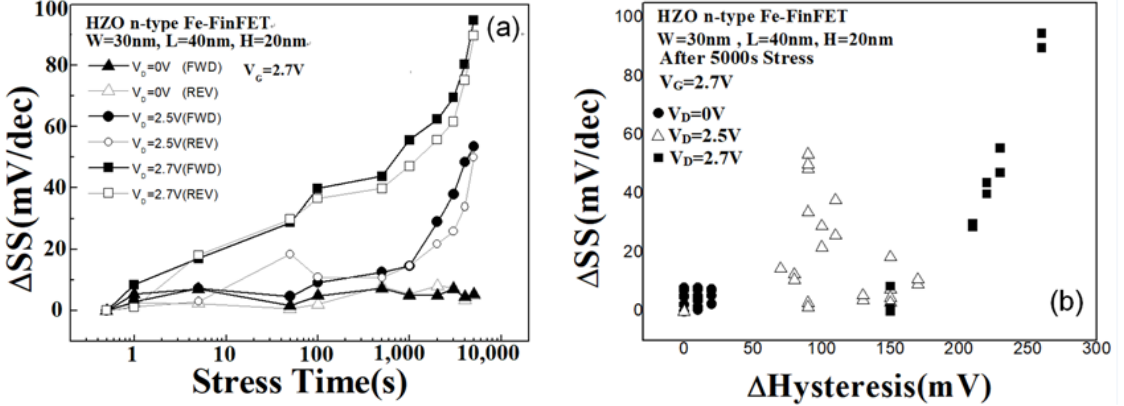
Figure 5. Subthreshold swing degradation ( a ) versus stress time and ( b ) versus hysteresis deviation after various voltage stresses for n - type Fe - FinFET.